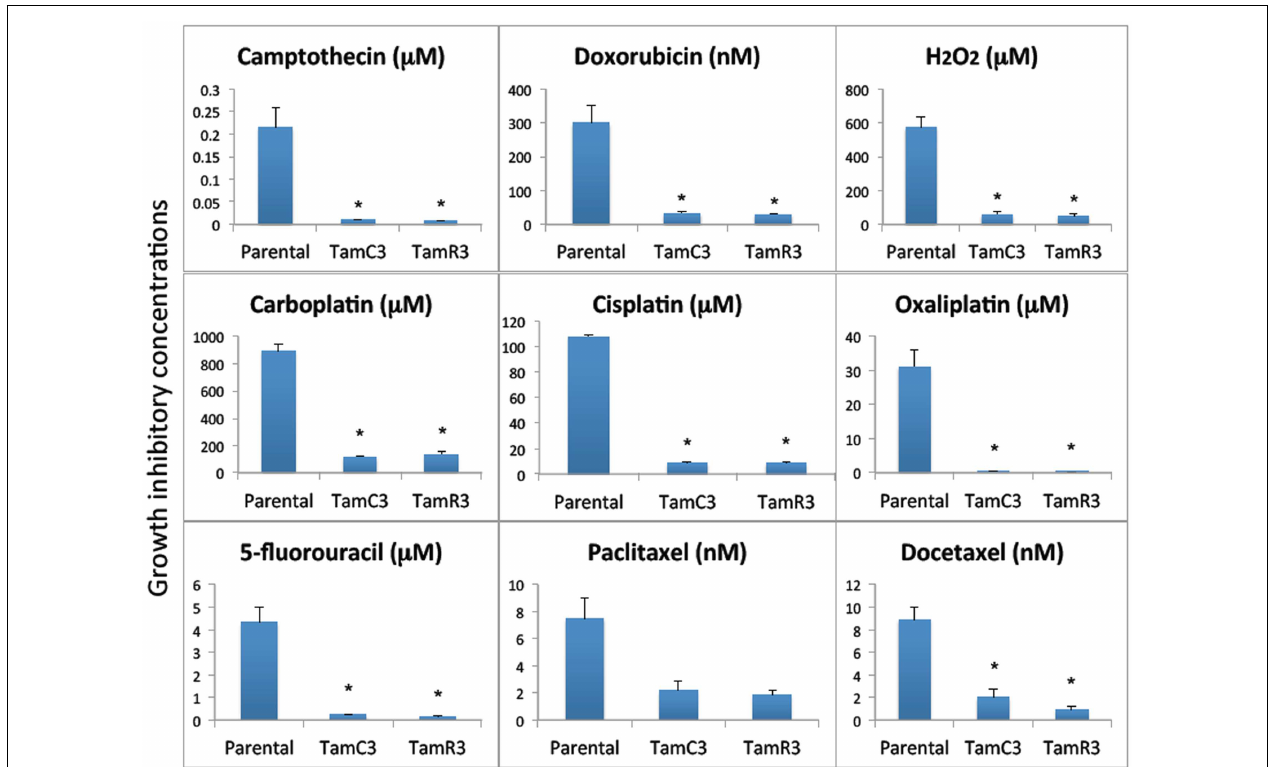
the other agents . Cells were treated with drugs for 3days and cell proliferation was measured by the sulforhodamine B assay. Bars indicate SE in two independent experiments. *Significantly different from MCF-7 parental line ( p <